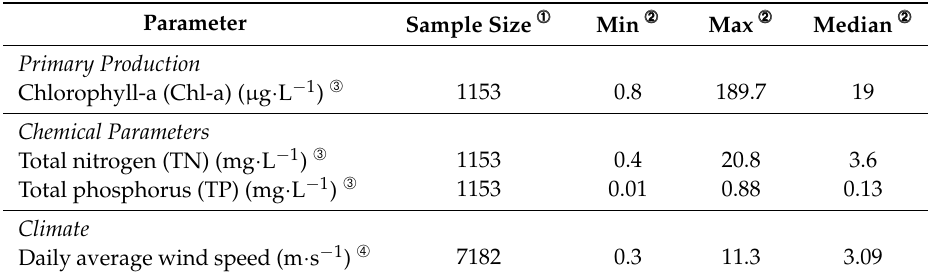
Table 1. Summary statistics of the historical